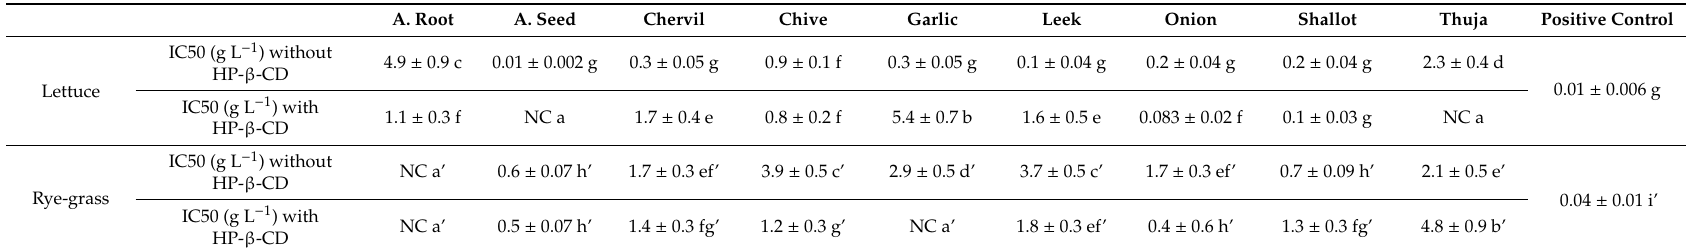
Table 4. IC50 of EO’s phytotoxic activity (inhibition of seedling’s emergence) obtained by contact assay, against lettuce and